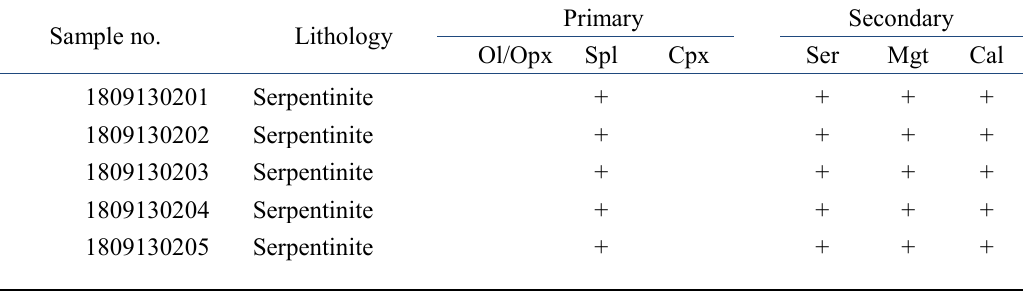
Table 1. Mineral assemblages of samples collected from the Manlay Ophiolite. Ol = Olivine, Opx = Orthopyroxene, Spl = Spinel, Cpx = Clinopyroxene, Ser = Serpentine, Mgt = Magnetite, Cal =